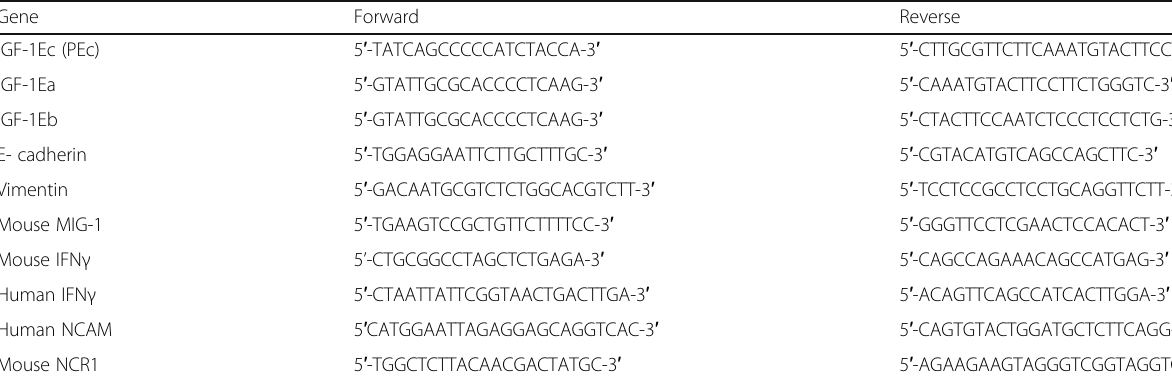
Table 1 Primers used in this